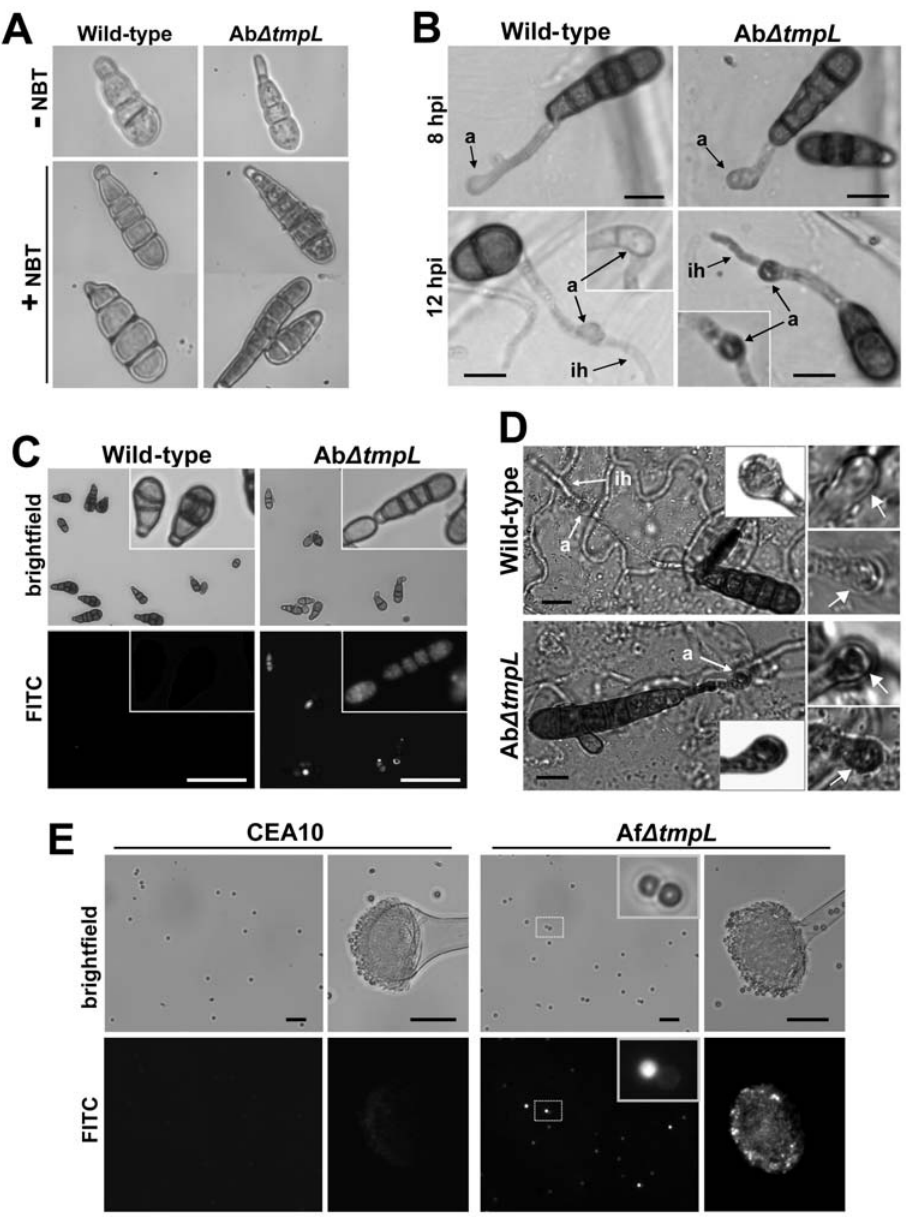
Figure 7. Excess ROS production during conidiation and infection in D tmpL mutants. ( A ) Accumulation of excess superoxide in the conidia of the A. brassicicola D tmpL mutants. 7-day-old conidia of A. brassicicola wild-type and D tmpL mutant grown on a nutrient-rich medium were strained with nitroblue tetrazolium (NBT) to detect superoxide. Each micrograph shows the picture of conidium before ( 2 ) and after ( + ) NBT staining. ( B ) Accumulation of excess superoxide in the mature appressoria and emerging infection hyphae of the A. brassicicola D tmpL mutants. Conidia of A. brassicicola wild-type and D tmpL mutant were inoculated on onion epidermis, incubated at room temperature for 8 and 12 hr, and stained with NBT. Insets show another example of appressorium stained with NBT from each strain. Bars=10 m m. Abbreviations: a, appressorium; ih, infection hypha. ( C ) Accumulation of excess ROS in the conidia of the A. brassicicola D tmpL mutants. Conidia released from 7-day-old colonies were stained with H 2 DCFDA and viewed by epifluorescence microscopy. Insets show a magnified view of conidia stained with H 2 DCFDA from each strain. Bars=50 m m. ( D ) Accumulation of excess H 2 O 2 in mature appressoria of the A. brassicicola D tmpL mutants. Conidia of the A. brassicicola wild-type and D tmpL mutant were inoculated on green cabbage cotyledons and incubated at room temperature for 12 hr before being stained with 3,3 9 - diaminobenzidine tetrahydrochloride (DAB). Insets are the magnified view of each appressorium. Right panels are the pictures of two more appressoria (arrows) stained with DAB from each strain, showing a typical range of staining intensity. Bars=10 m m. Abbreviations: a, appressorium; ih, infection hypha. ( E ) Accumulation of excess ROS in the conidia of the A. fumigatus D tmpL mutants. Conidia and conidiophores of the A. fumigatus wild-type (CEA10) and D tmpL mutant were released from 3-day-old colonies and subsequently stained with H 2 DCFDA for 30 min and 1 hr, respectively, and viewed by epifluorescence microscopy. Bars=20 m m.